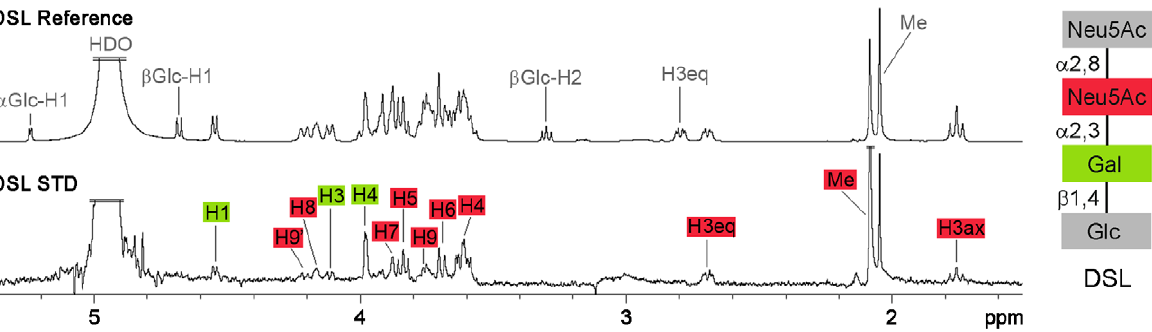
Figure 2. MCPyV VP1 epitope mapping of DSL. 1 H-NMR-spectra showing the binding epitope of DSL binding to MCPyV VP1 in solution. Top: DSL reference spectrum, bottom: STD spectrum in the presence of MCPyV VP1. Assignments are color-coded according to the DSL cartoon. Signals in the STD spectrum belong to the Neu5Ac- a 2,3-Gal motif in DSL only. One methyl group and residual HDO peaks are truncated. Spectra were recorded at 283 K.